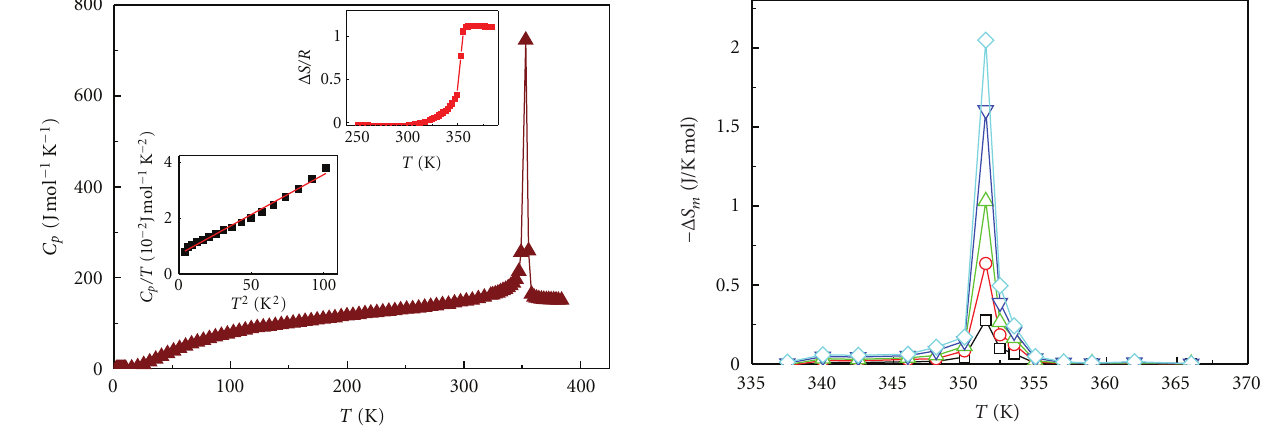
of Mn SbN. e le /T versus curve and an 3 𝐶𝐶 𝑝𝑝 2 𝐶𝐶 𝑝𝑝 𝑇𝑇